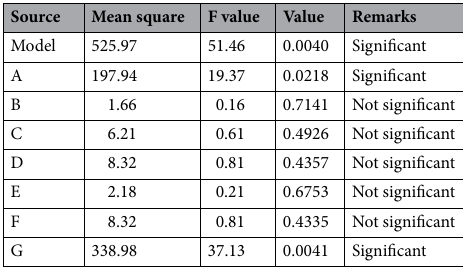
Table 4. ANOVA results.